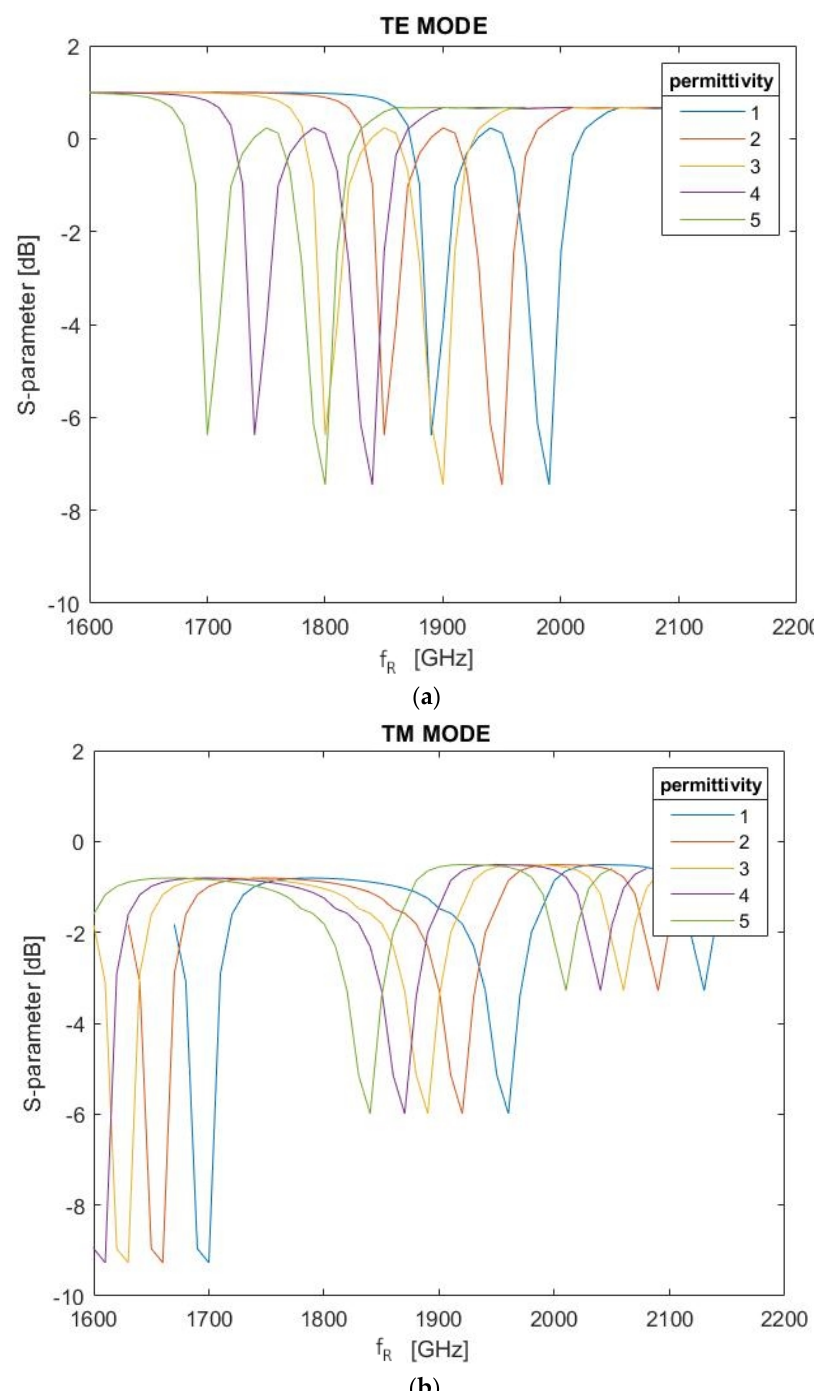
Figure 10. S 11 frequency response change caused by various permittivities of an additional layer for geometry Q = 0 µm and U = 8 µm with larger sample step equal to 0.01 THz: ( a ) TE mode, ( b ) TM mode.